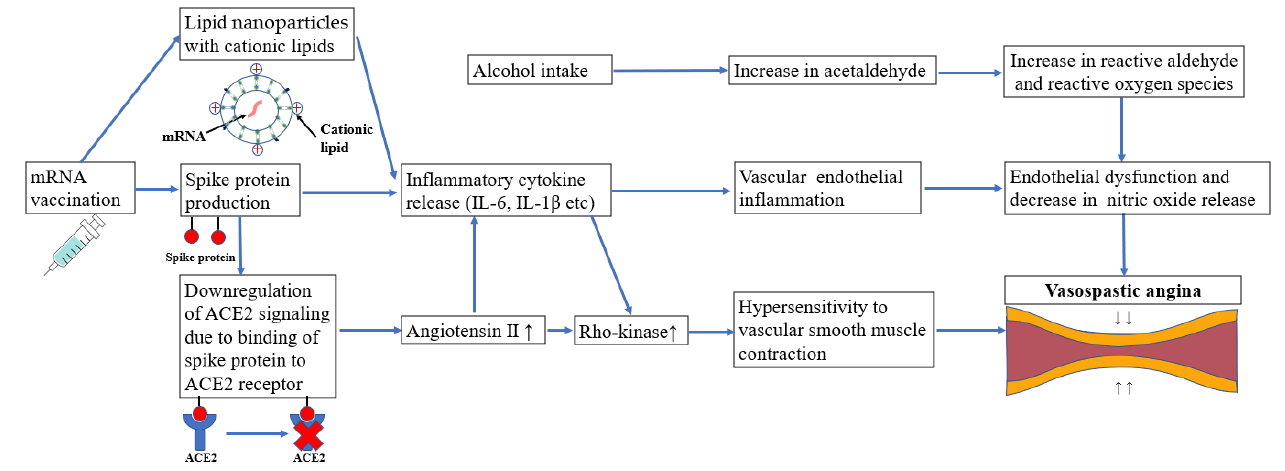
Figure 2. The potential mechanisms of vasospastic angina following mRNA vaccination in this case. mRNA, messenger RNA; IL, interleukin; ACE2, angiotensin-converting enzyme 2.